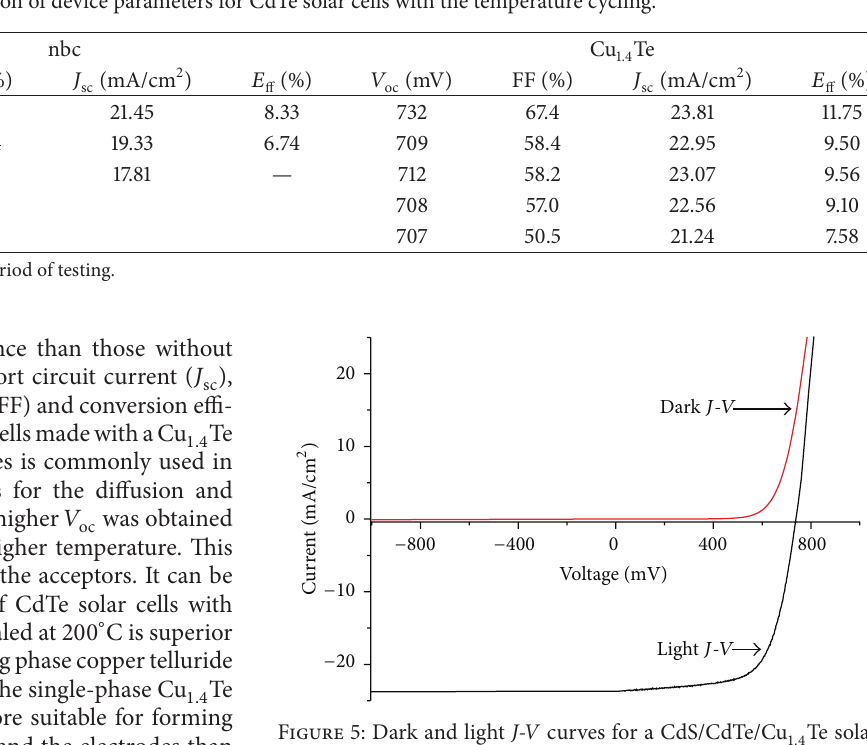
Table 2: Device parameters for CdTe solar cells with or without Cu